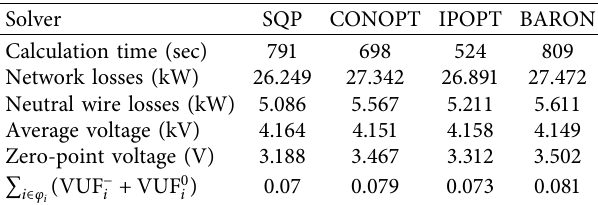
Table 8: Convergence state of proposed scheme in case VI for diferent